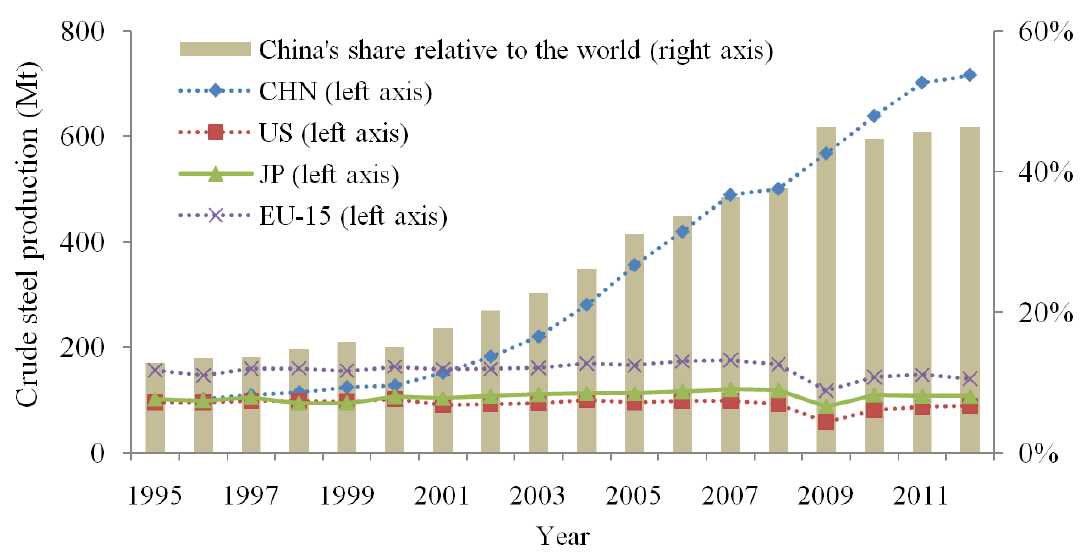
Figure 1. Crude steel production in China and the world. (Source: revised from [5] by the